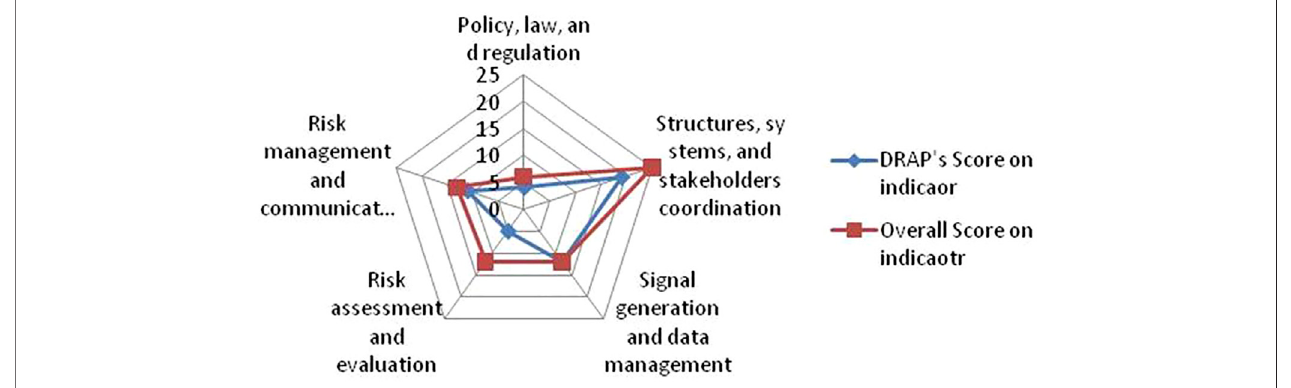
FIGURE 2 | Five-axis spider-diagram (0 – 25 score) showing the DRAP ’ s scores on fi ve main indicators of